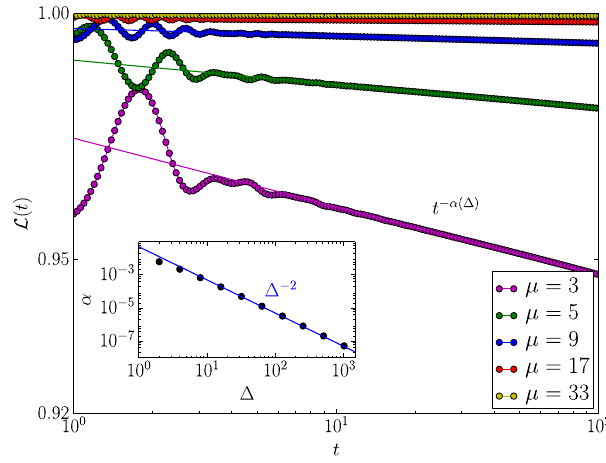
0 to , and Δ 2 s ¼ ≠ 0 show exactly the same s